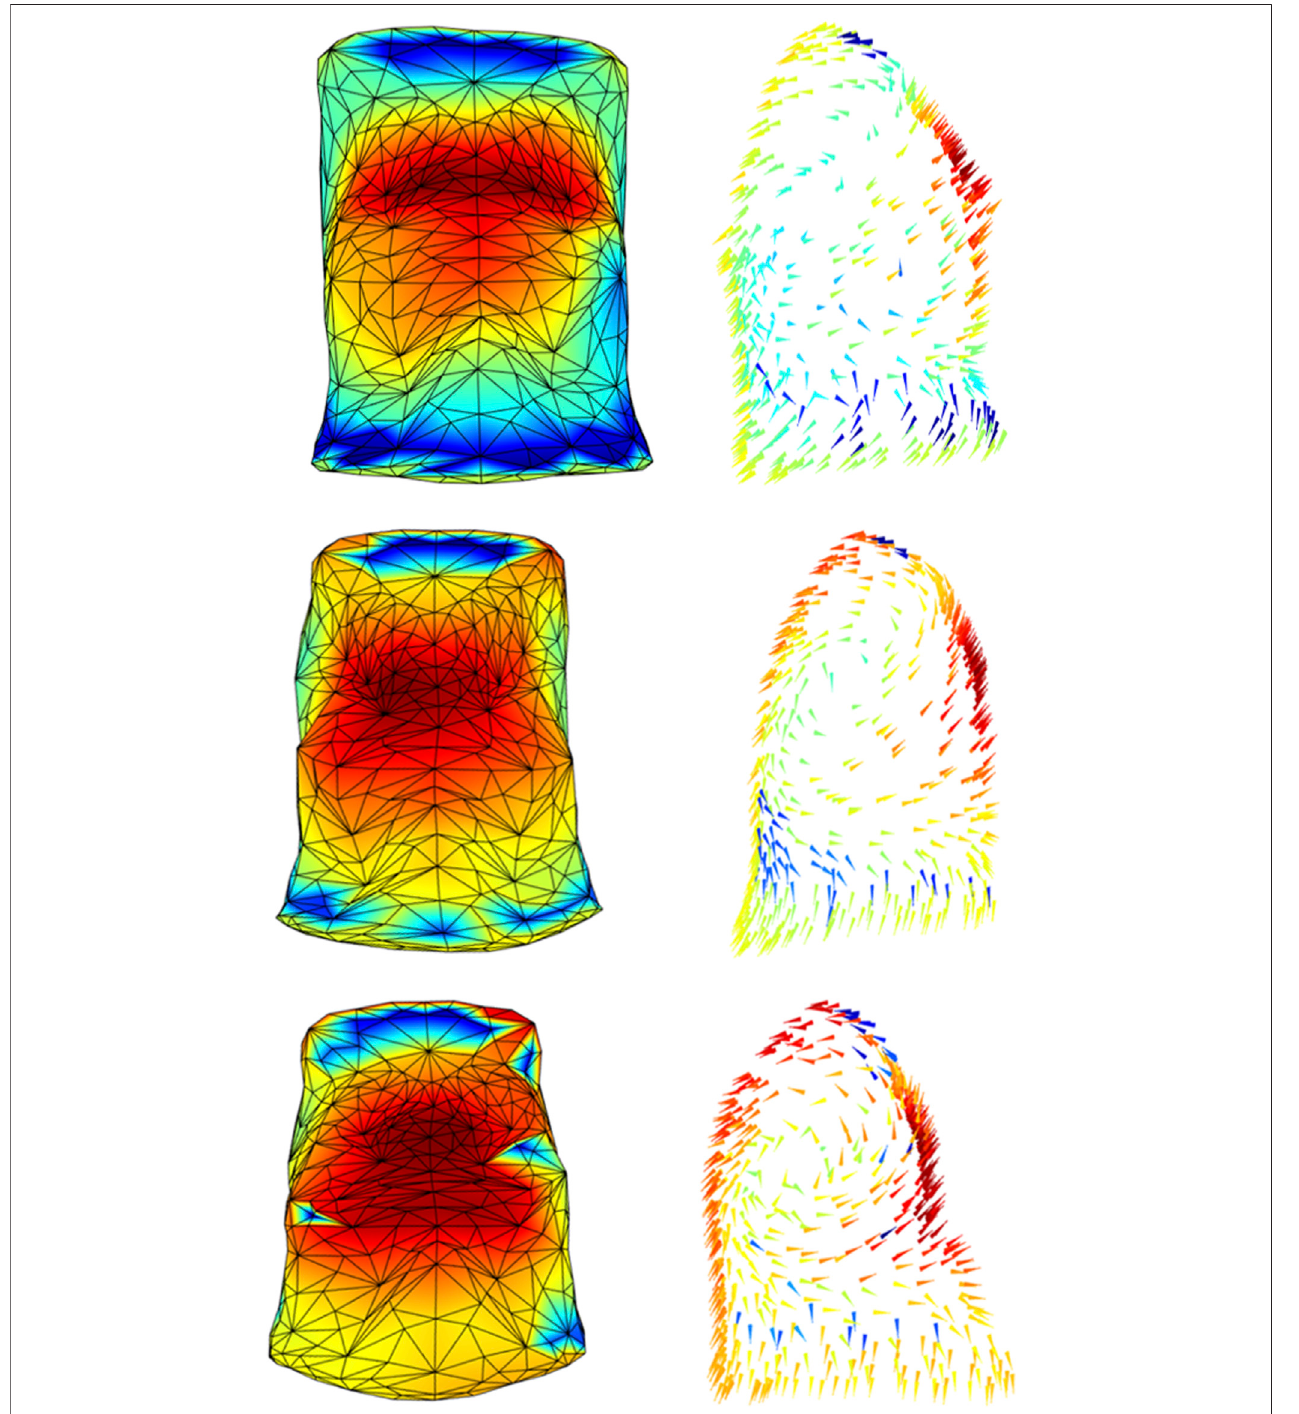
FIGURE 5 | Colormaps of the magnitude (left panels) and vector direction (right panels) of the trunk motion during the tidal volume of a woman studied at the 15th (top panels), 20th (middle panels), and 32nd (bottom panels) gestational weeks. In line with the literature, the progression of pregnancy breathing was associated with increased abdominal expansion (from azure-blue of the top panel to yellow-red of the bottom panel). These two extreme and opposite case series, the fi rst implying localized and symmetric abdominal expansion and the second anatomical compartment. asymmetric and asynchronous ribcage expansion, encourage the